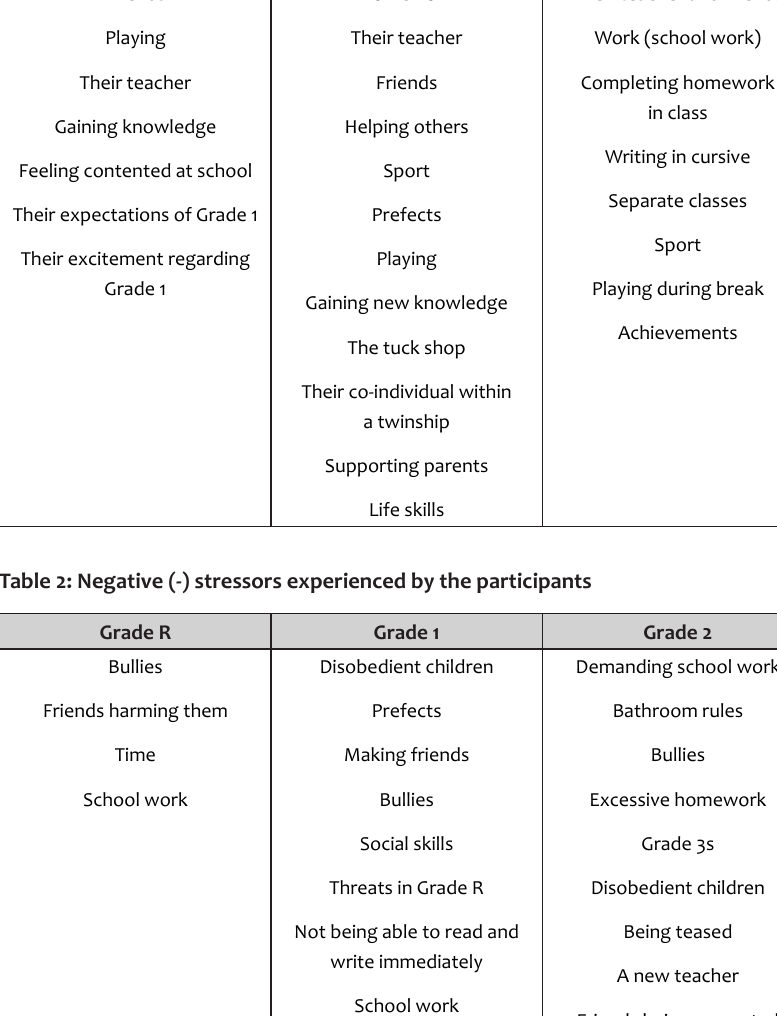
Table 1: Positive (+) stressors experienced by the participants Grade R Grade 1 Grade 2